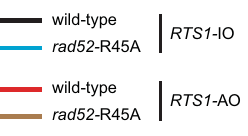
Fig. 6 | Rad52 ’ s DNA annealing activity drives template switching between diverged Alu elements. a Schematic showing the Alu Sx1- Alu Sp recombination reporterinserted12.4kbdownstreamof RTS1 onchromosome3.Theupperpartof the panel shows a map of the chromosome 3 region where RTS1 and the Alu Sx1- Alu Sp recombination reporter are inserted. Replication origins are indicated by brown circles. Black and red arrows indicate the direction of canonical replication and RDR, respectively. The lower part of the panel shows the Alu Sx1- Alu Sp recombination reporter. Primers A and B are used to amplify the Alu Sx1- Alu Sp region for analysis of recombinant products. b Frequency of spontaneous ( RTS1 - IO) and RTS1 -AO-induced Ura − His − recombinants in wild-type and rad52 -R45A mutant strains with ori-1253 Δ and the Alu Sx1- Alu Sprecombination reporter shown